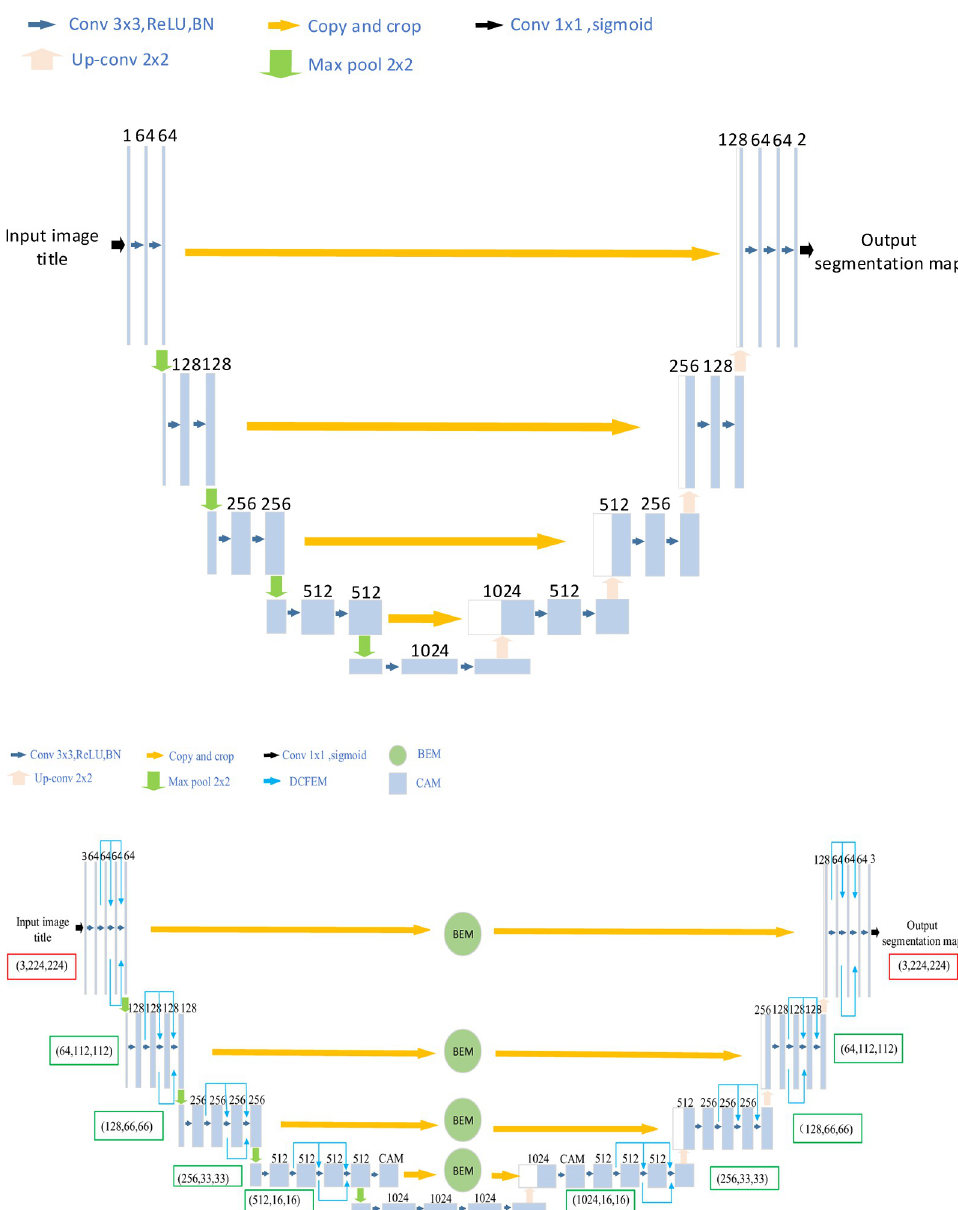
Fig 2. Network structure diagrams of U-Net and BC-DUnet. (a) U-Net network structure. (b) BC-DUnet network structure.